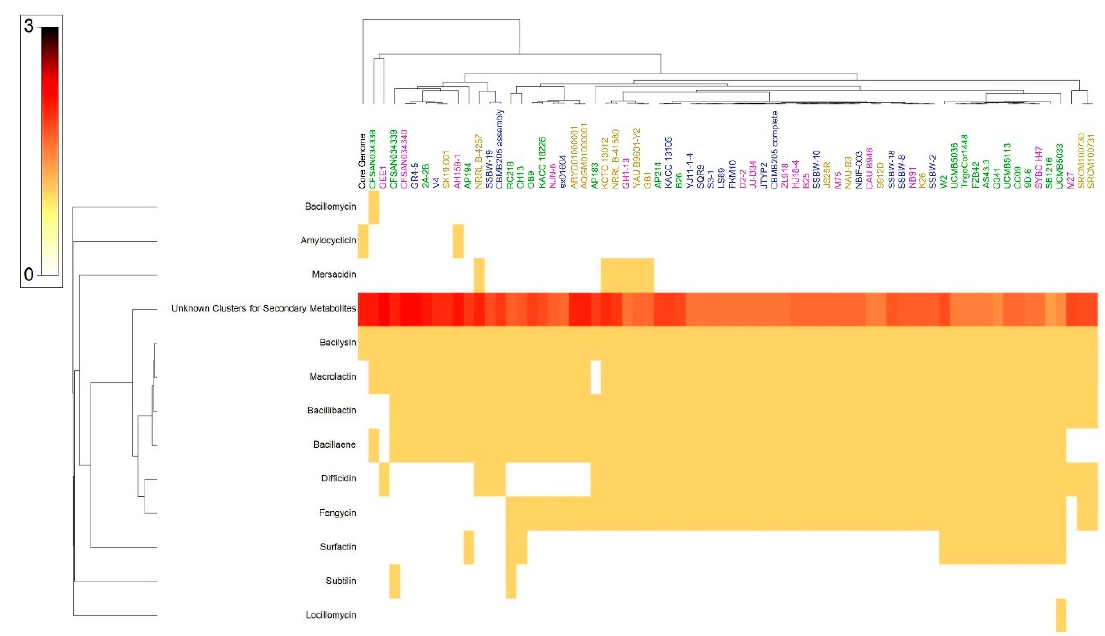
Figure 6. Heat map of B. velezensis accessory genome secondary metabolites clusters. The number of secondary metabolites clusters varied between 0 and 3. Table 2. Results retrieved from the LC-MS analysis of the B. velezensis strain